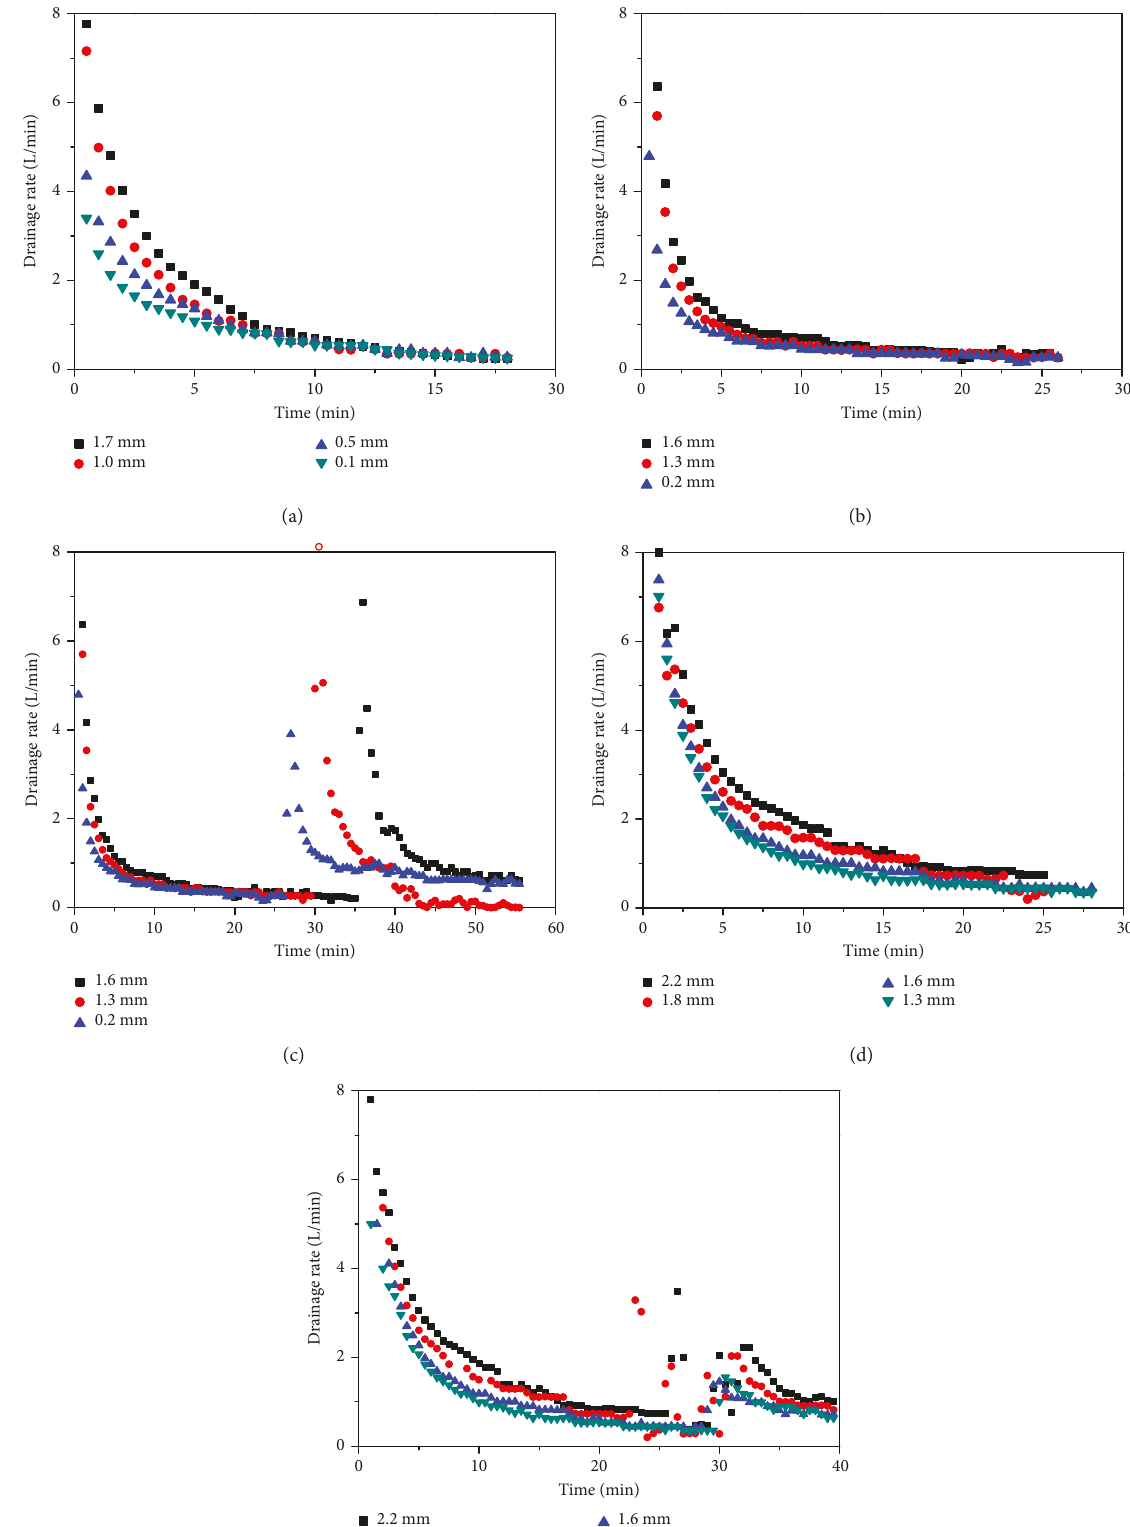
Figure 8: Drainage rate with di ff erent fracture apertures: (a) CI (without gas drive), (b) CII (without gas drive), (c) CII (with gas drive), (d) CIII (without gas drive), and (e) CIII (with gas